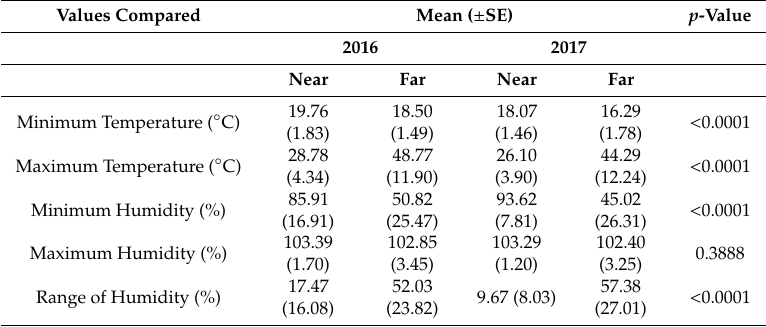
Table 1. Mean ( ± SE) temperature and humidity collected by sensors placed near and far from piles of woody debris over a 2-day period in 10 harvested sites in western North Carolina during summer 2016 and 2017. The p -value given is from an analysis of variance with proximity as the dependent variable. Means are presented by year and proximity to show that relationships were consistent across the two years.